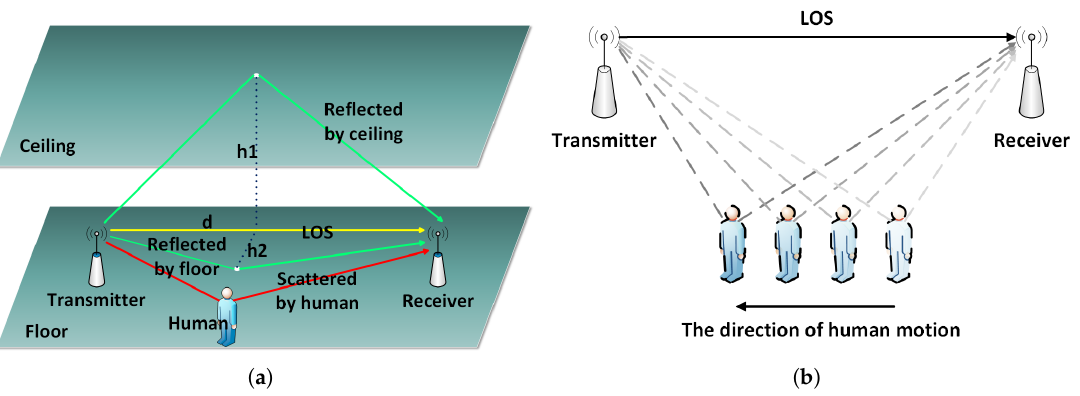
Figure 2. The indoor multi-path effects are affected by human body when people appear. ( a ) Shows the indoor signal propagation model. ( b ) Depicts the influence to wireless signal propagation paths caused by human